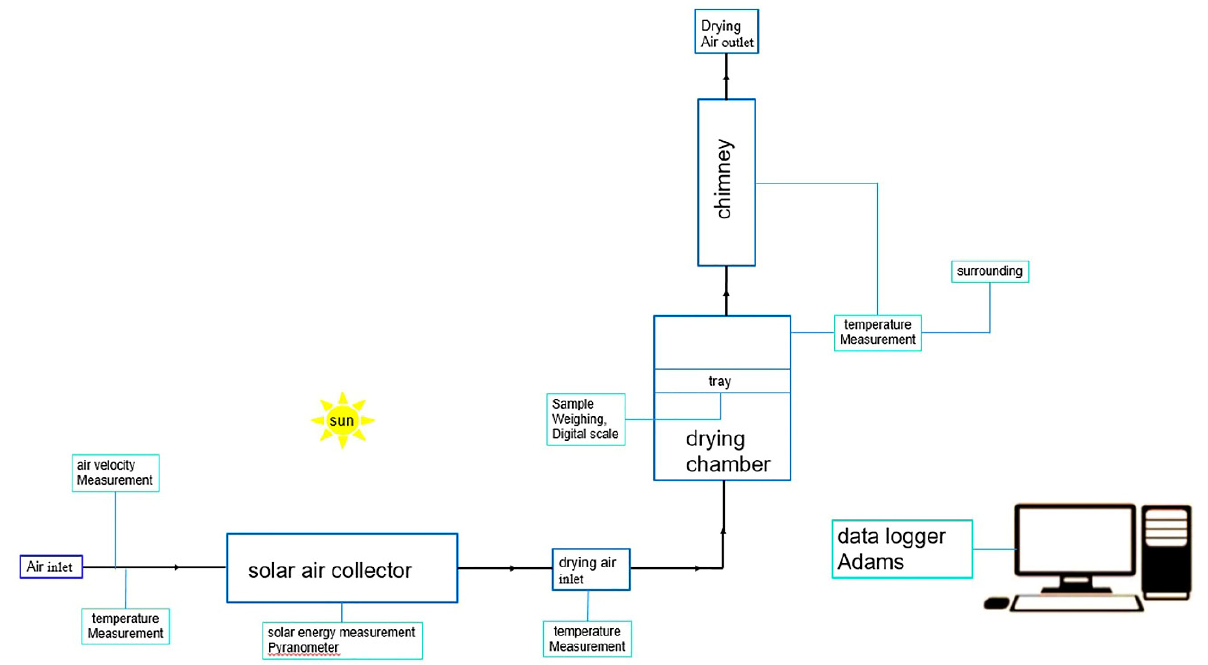
Figure 3. Schematic diagram of the solar drying unit Dhaundiyal et al., 2021 [31].